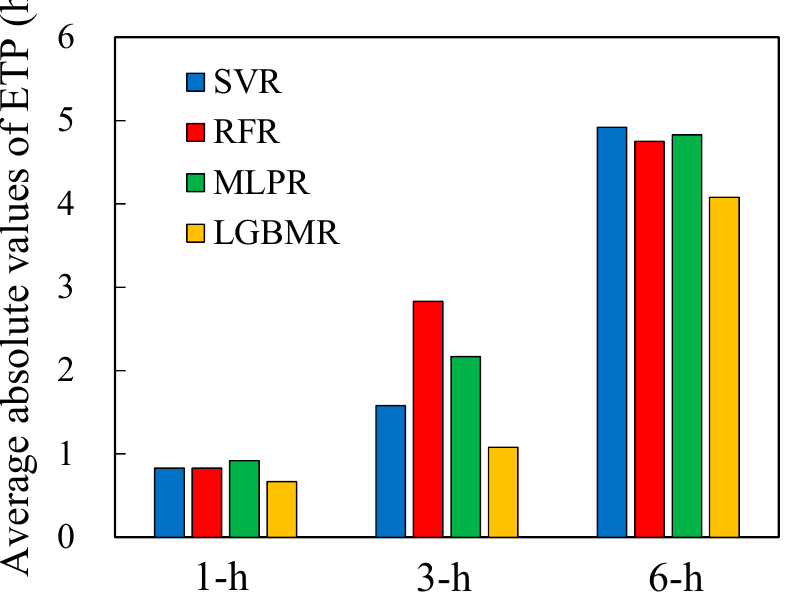
Figure 12. The average absolute values of error of time-to-peak water level (ETP) by four models for 1-, 3-, and 6-h lead times.